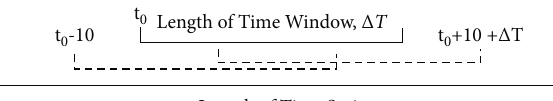
Figure 14: The schematic for the calculation of the error bars for the time window of length, Δ T , with a starting position, t window by ± i , where i � 0 − 10 days, and work out the value of the moments for this window. We take either the raw values of the moments and the maximum and minimum values of the range or the standard deviation of this, as described in the text.